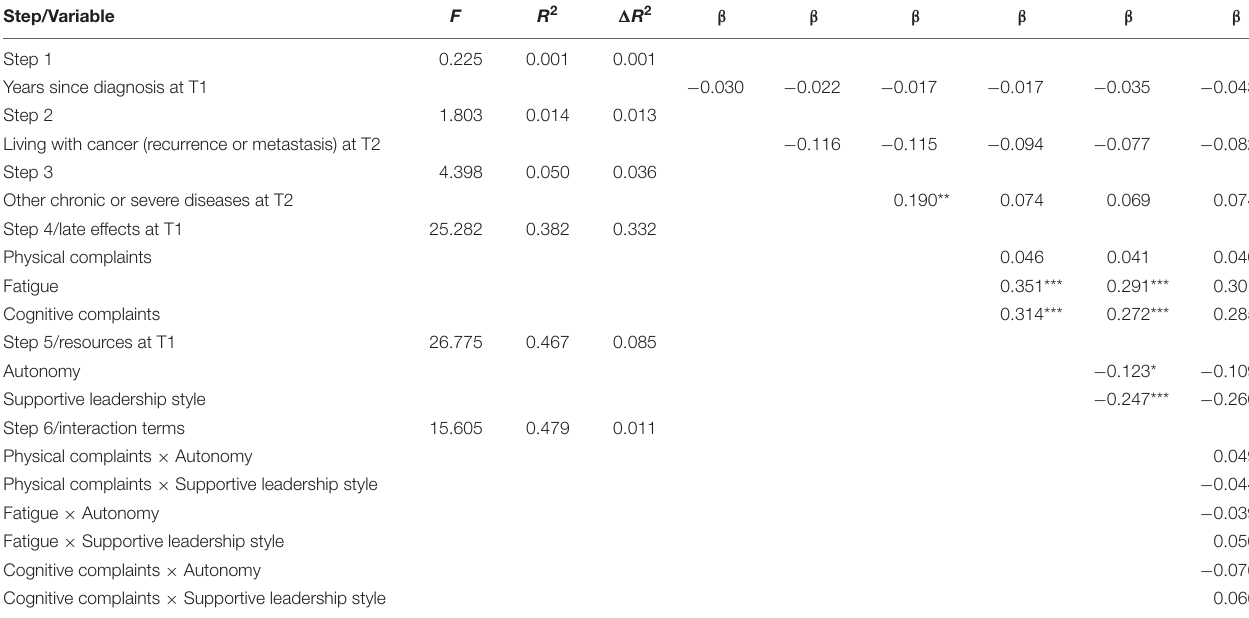
TABLE 3B | Multivariate regression analyses for moderation by autonomy or supportive leadership style (at T1) of the association of physical complaints, fatigue, or cognitive complaints (at T1) with burnout complaints (at T1), controlled by years since diagnosis, living with cancer (recurrence or metastasis) and other chronic or severe